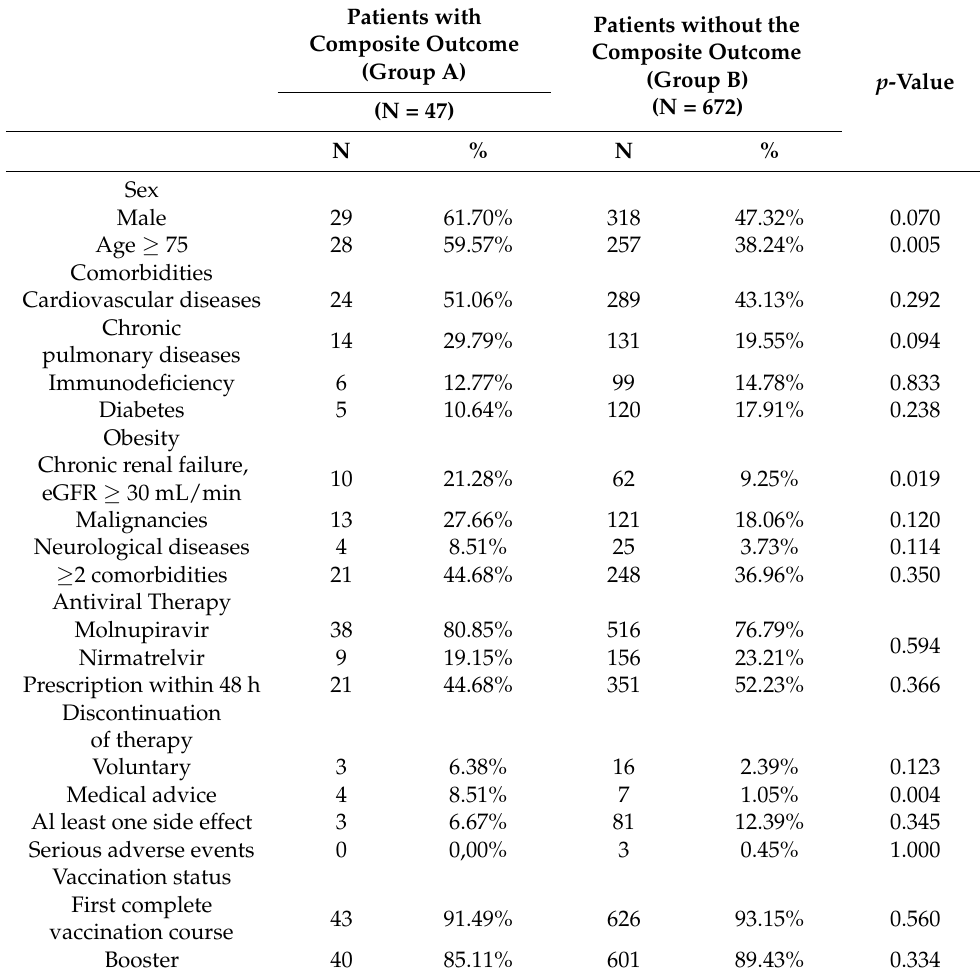
Table 3. Clinical characteristics according to the composite outcome (hospitalization and/or death at 30